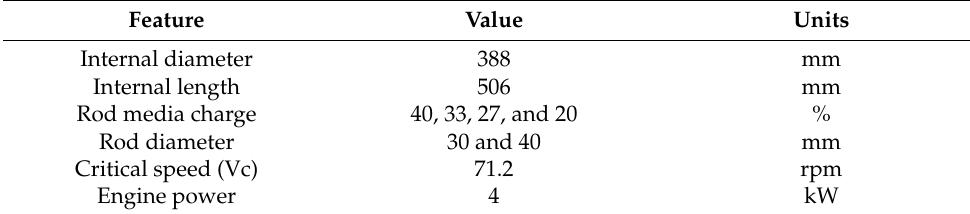
Figure 2. Laboratory tumbling rod mill design. ( A ) Profile view, ( B ) 35 mm lifter height configura- tion, ( C ) 23 mm lifter height configuration.